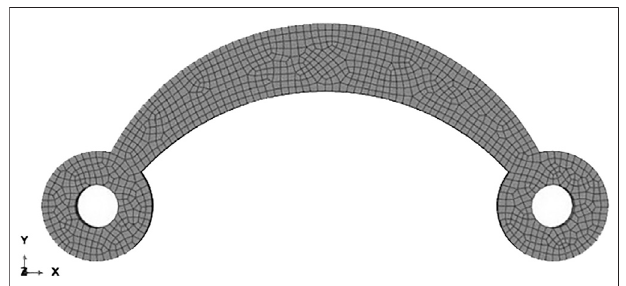
FIGURE 1 | Finite element scheme of the dissipative